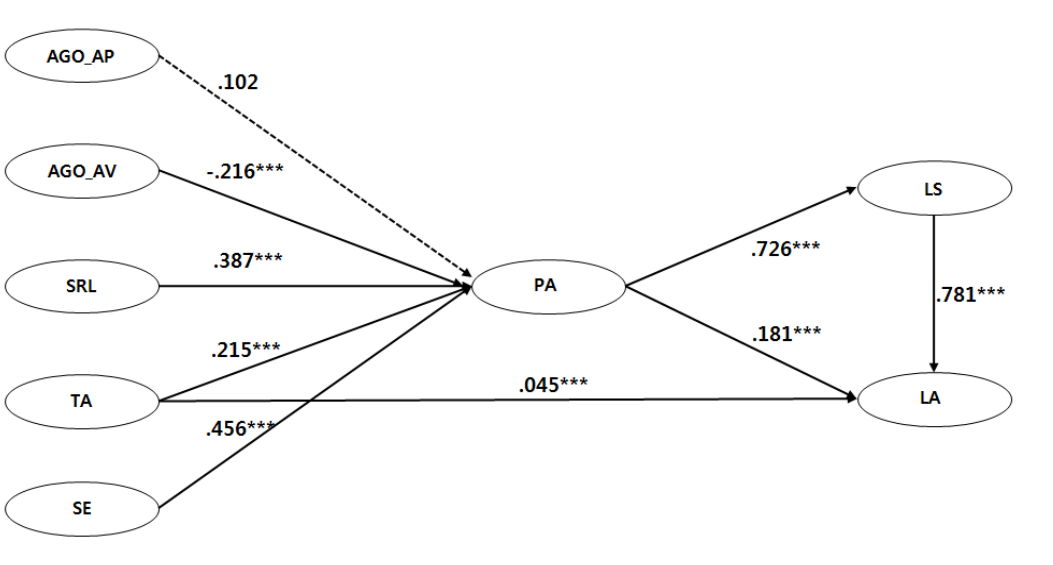
Figure 1. Structural relationships between variables. AGO_AP : Achievement Goal Orientation related to APproach, AGO_AV : Achievement Goal Orientation related to AVoidance, SRL : Self-Regulated Learning, TA : Test Anxiety, SE : Self Efficacy, PA : Participation, LS : Learning Satisfaction, LA : Learning